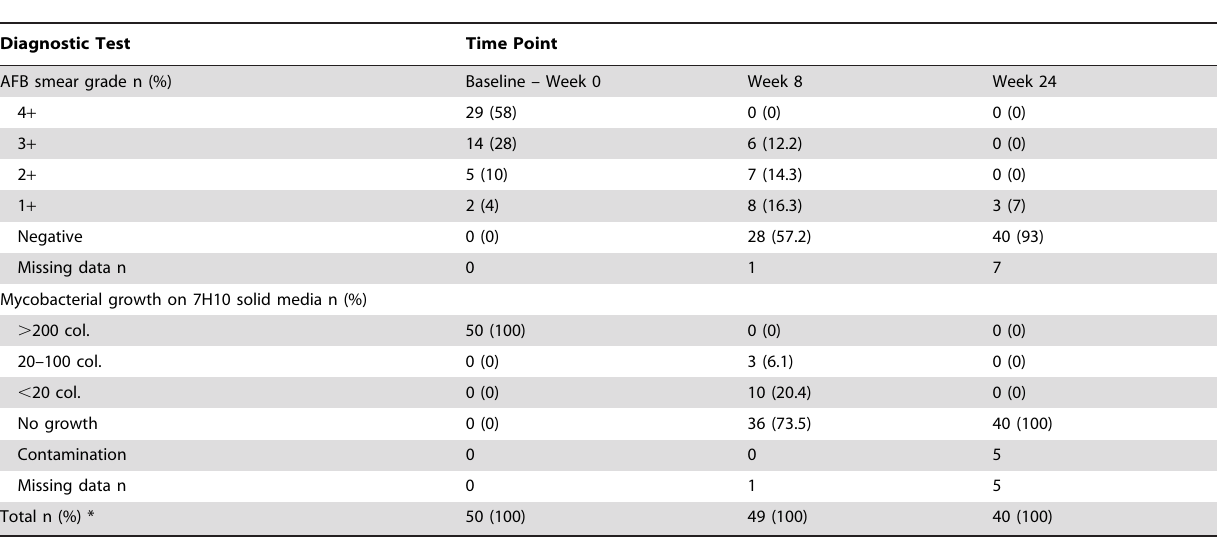
Table 2. Microbiologic burden of mycobacterium tuberculosis in relation to duration of